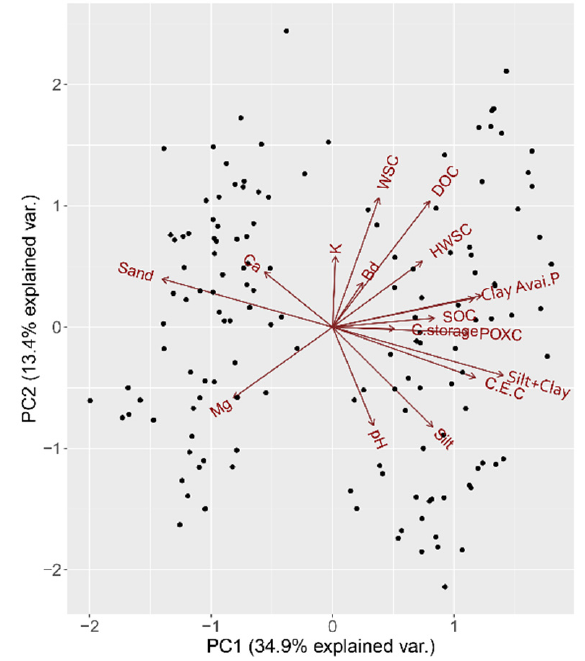
Figure 9. Principal component analysis (PCA) explaining labile carbon and physicochemical soil properties that influence SOC content and carbon storage resulting from rice rotation with different cropping patterns in northern Thailand.